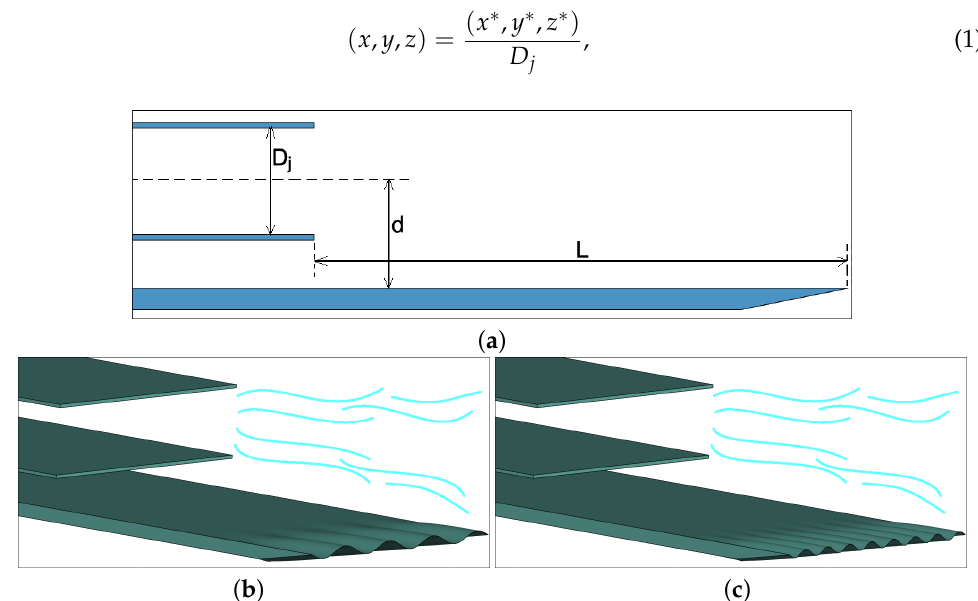
Figure 1. ( a ) The geometry of the nozzle and the plate; ( b , c ) two examples of trailing edge deforma- tions of different